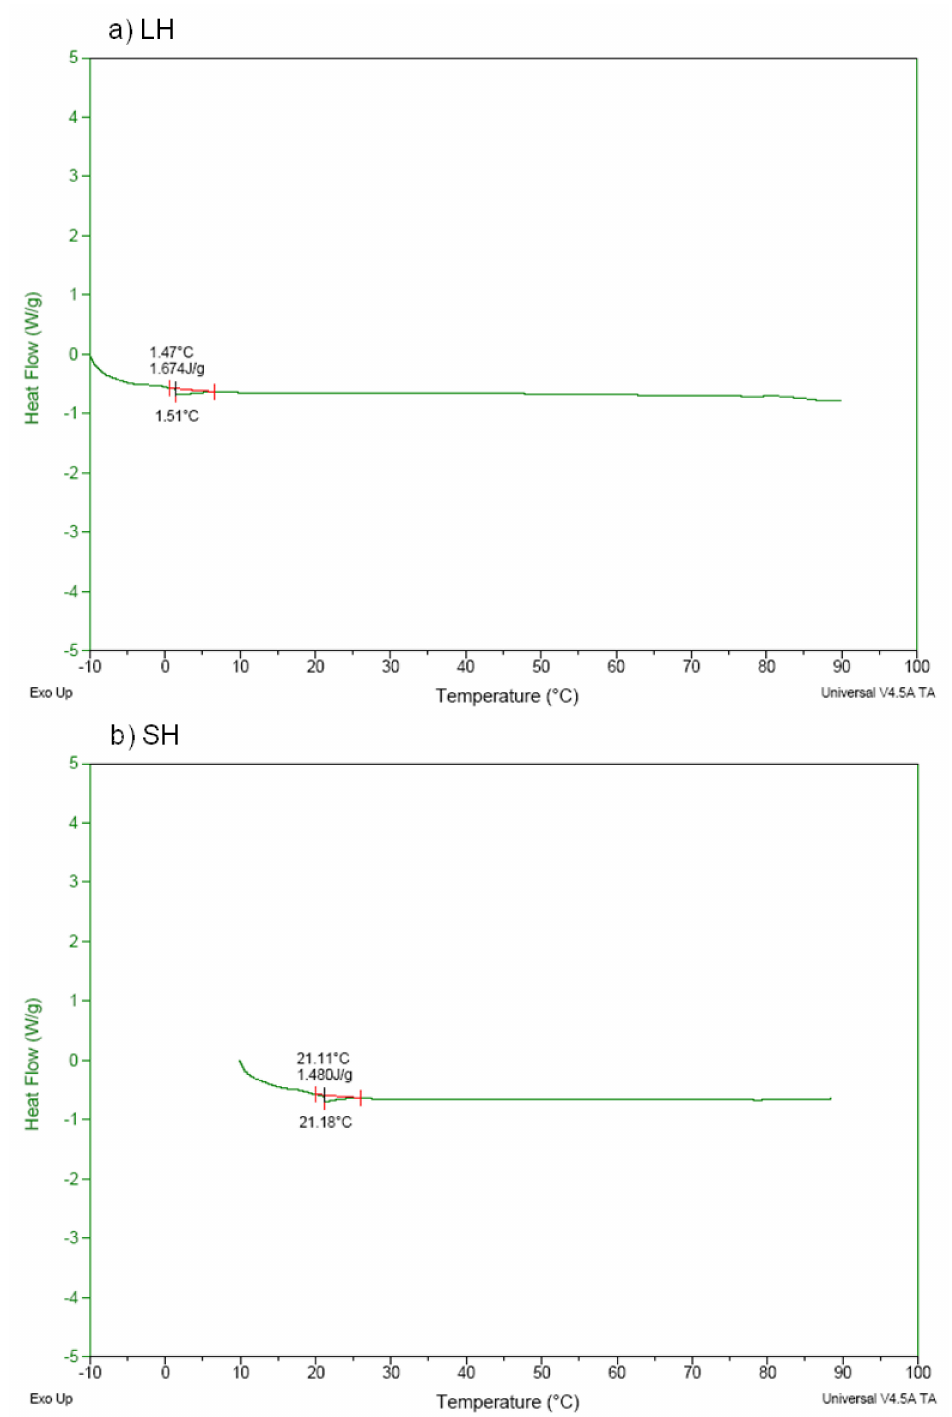
Figure 4. Differential scanning calorimetry (DSC) thermogram of the ( a ) lamb (LH) and ( b ) sheep (SH)